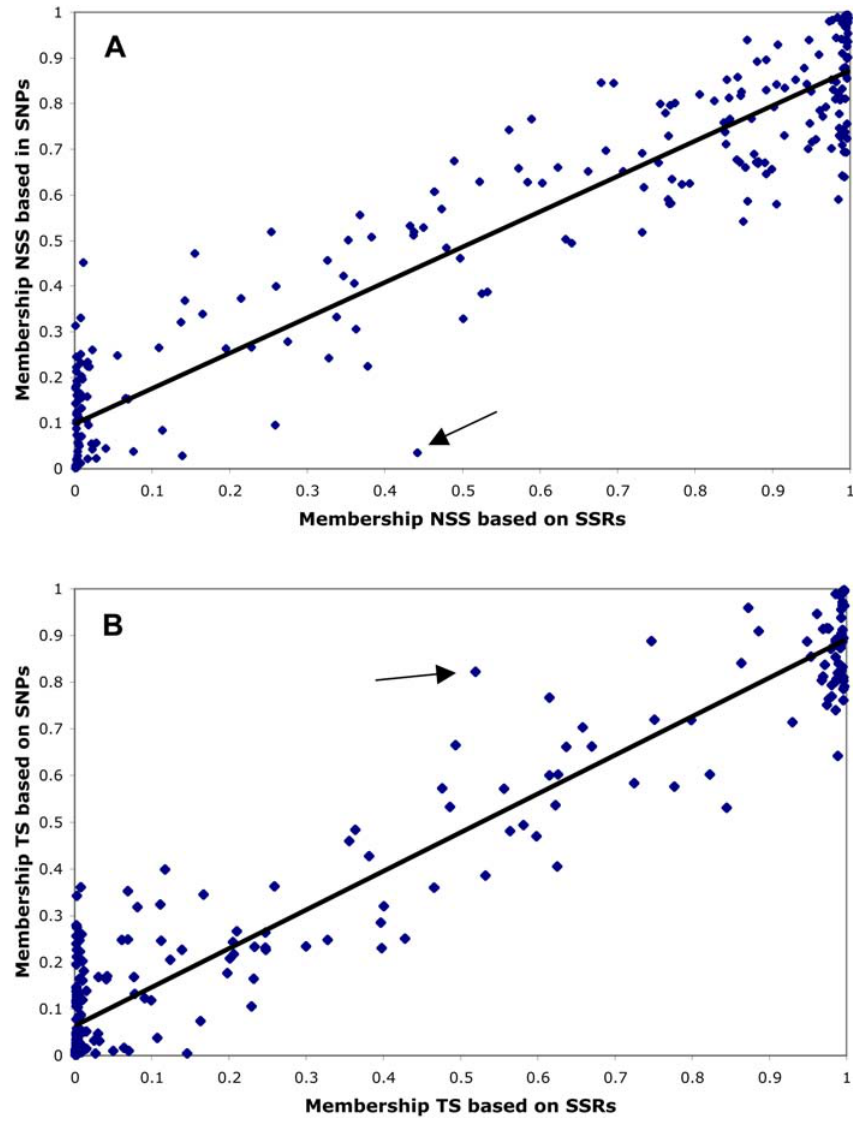
Figure 3. Comparison of membership in population clusters based on marker class. Each point represents one individual’s proportion of ancestry in the NSS (top panel) or TS (bottom panel) cluster, based on SSR (x axis) or SNP (y axis) data assuming three populations. The arrows indicate line F2834T (see text).